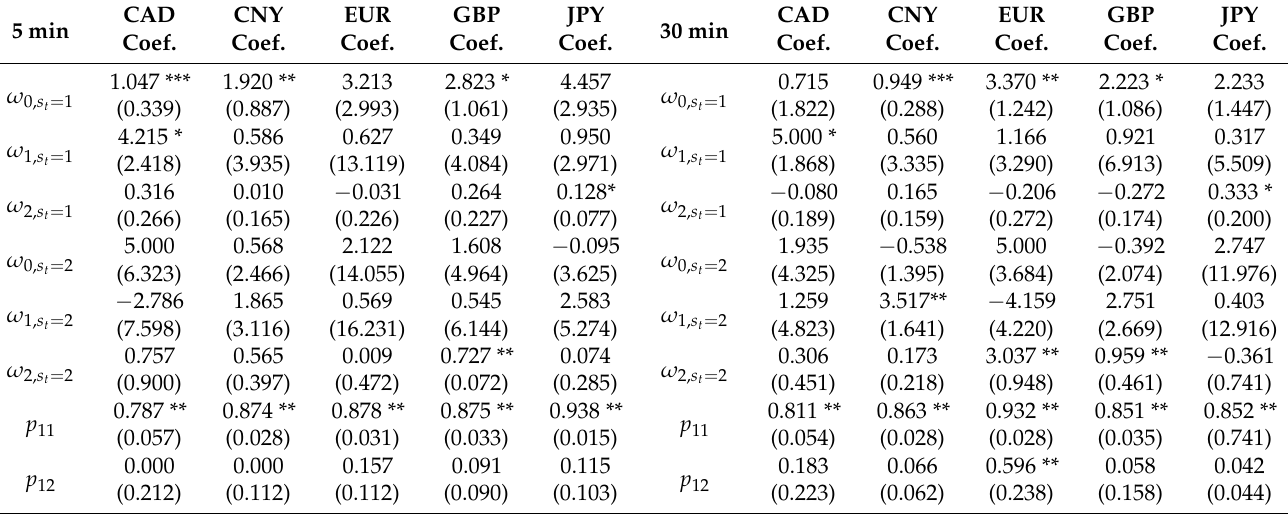
Table 11. Parameter estimates of the MSDC-GARCH